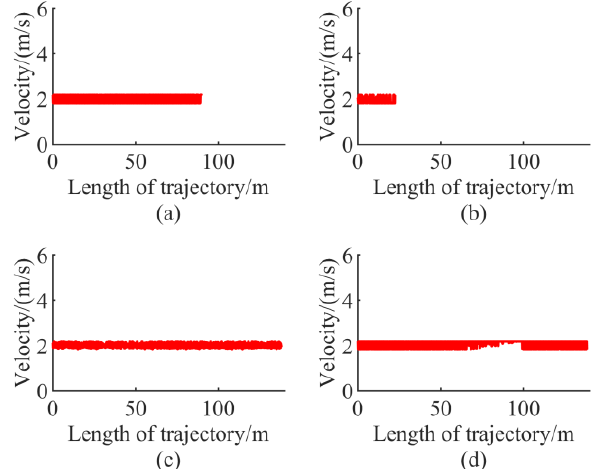
Figure 34. The velocity with the positioning error in ± 0.2 m. ( a ) LMPC. ( b ) LEMPC. ( c ) NMPC. ( d ) NEMPC.